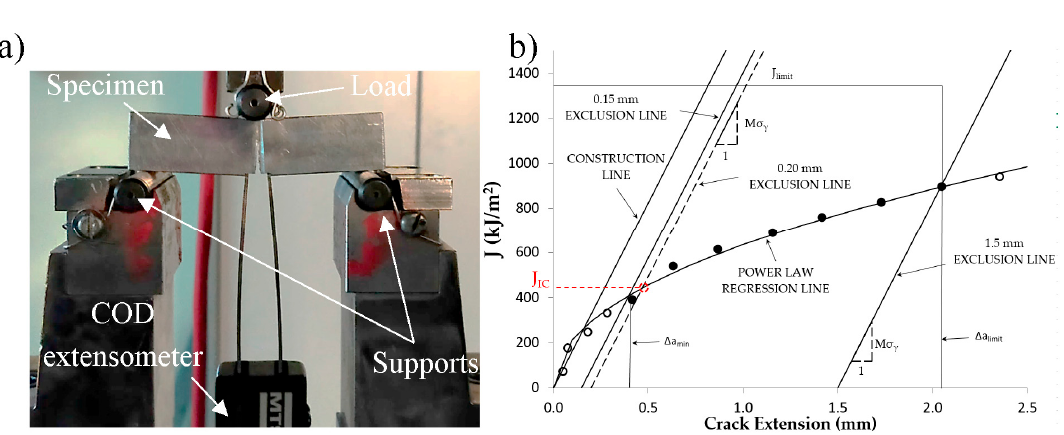
Figure 1. Fracture toughness tests. ( a ) Loading fixture, ( b ) J-R curve (without